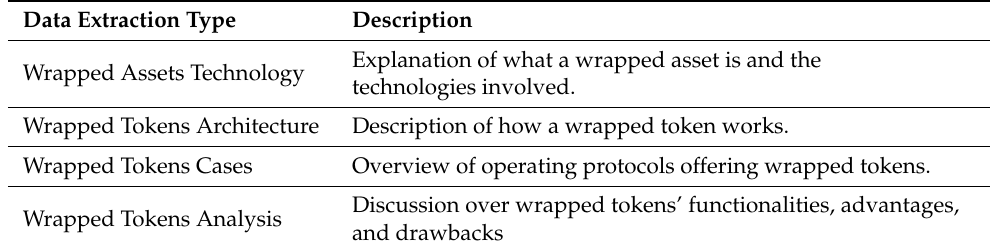
Table 1. Extraction variables.